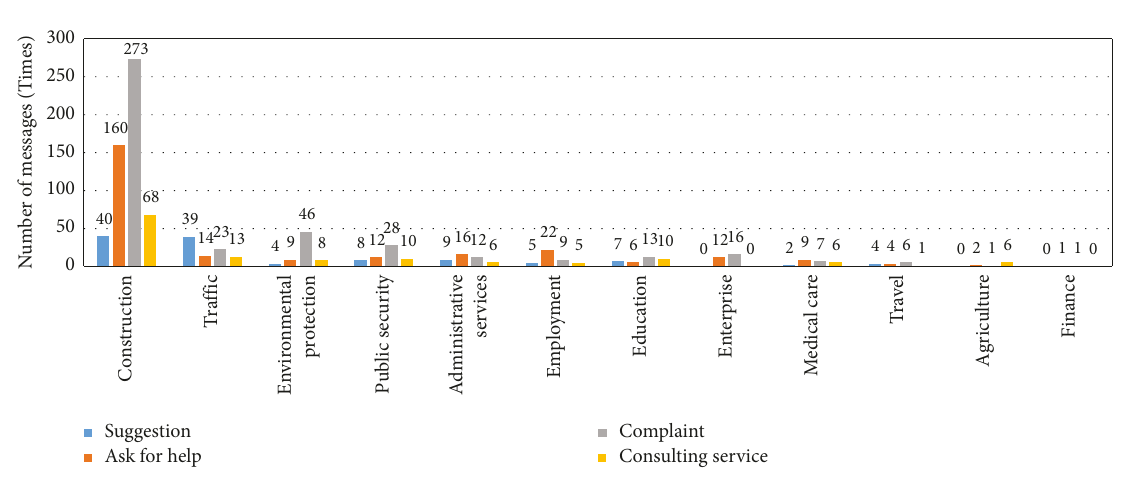
Figure 4: Statistics of people’s messages to government departments in J City.